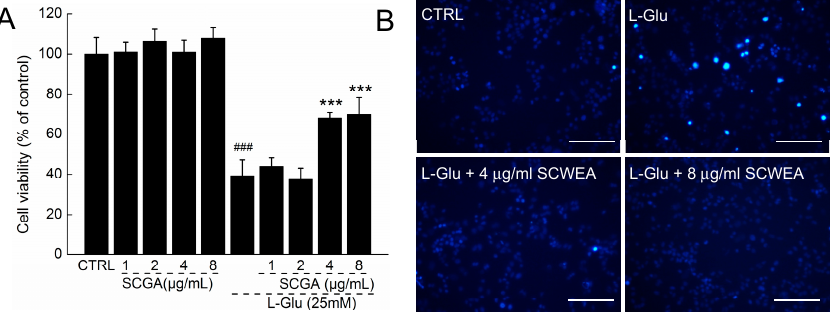
Figure 3. The neuro-protective effect of SCWEA against L -Glu-induced cell damage in DPC12 cells. Cells were pretreated with SCWEA for 3 h, and then co-incubated with or without 25 mM L -Glu for 24 h. Compared with L -Glu-treated cells, SCWEA enhanced cell viability ( A ) and reduced nuclear apoptosis rate (20×; Bar: 100 µm) ( B ). Data were expressed as a percentage of corresponding control cells and means ± S.D. ( n = 6). ### p < 0.001 versus control cells (CTRL); *** p < 0.001 versus L -Glu-exposed cells.